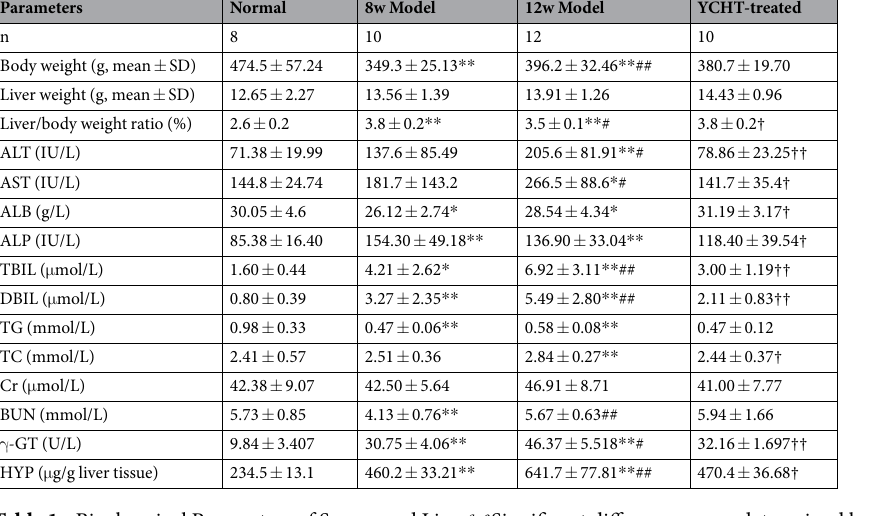
Table 1. Biochemical Parameters of Serum and Liver a . a Significant differences were determined by One-Way ANOVA. Asterisk ( * ) indicates P < 0.05, ** P < 0.01 vs . normal group. # P < 0.05, ## P < 0.01, vs . 8w model group. Dagger (†) indicates P < 0.05, †† P < 0.01, vs . 12w model group. Data are presented as mean ±